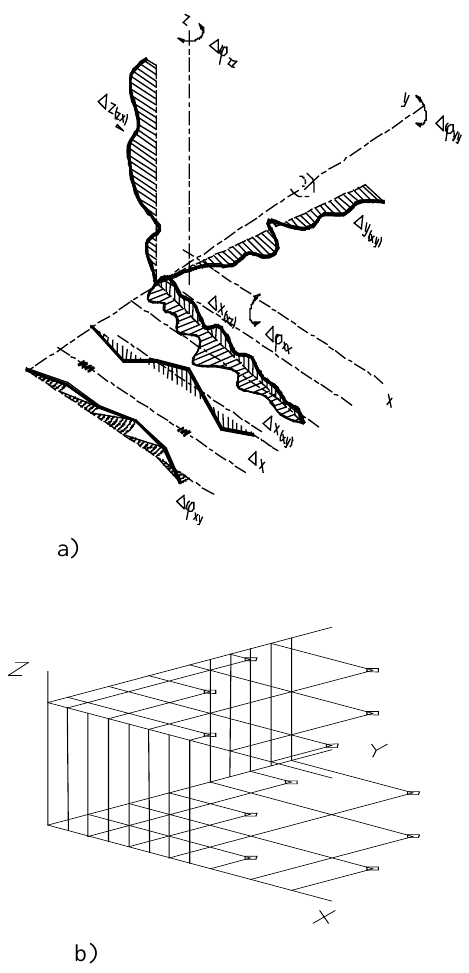
Fig 1 . Geometric errors distribution for machine product specification (a) and measuring points sampling in the measurement volume